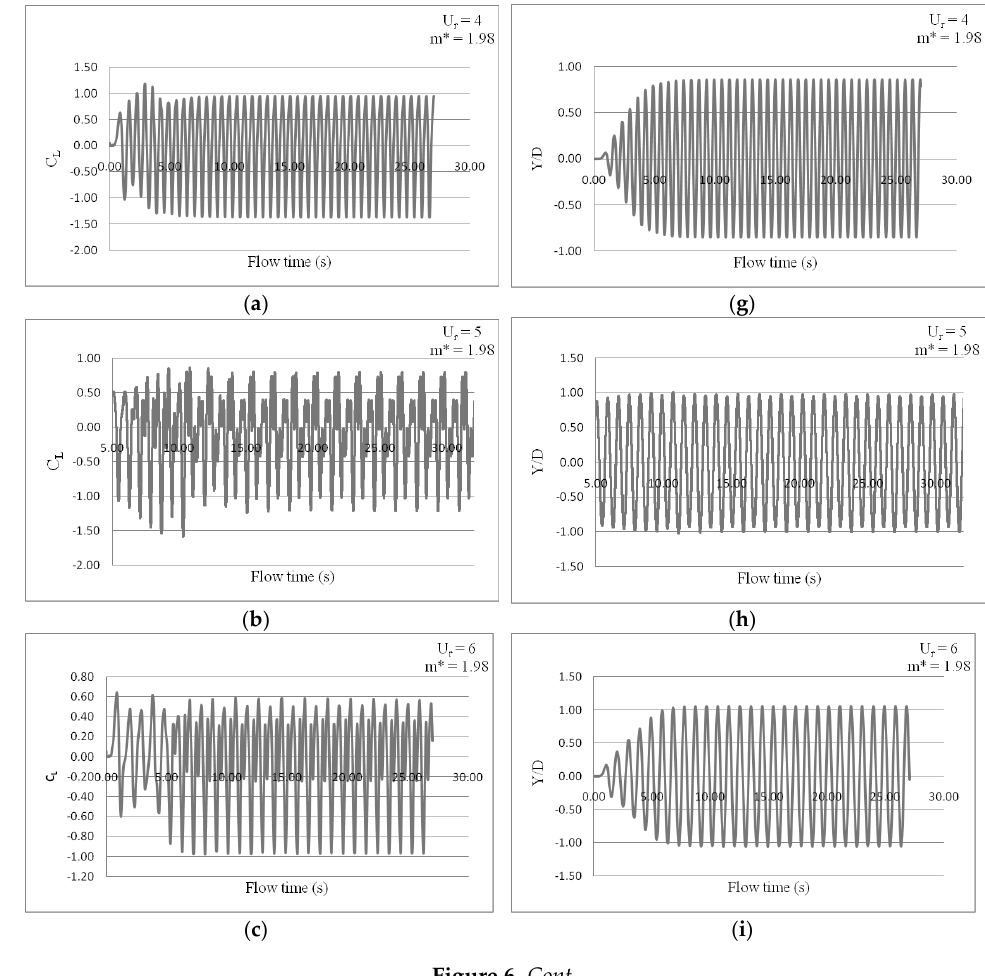
Figure 5. Time histories of hydrodynamic and structural response parameters at m* = 1.32: ( a ) C L